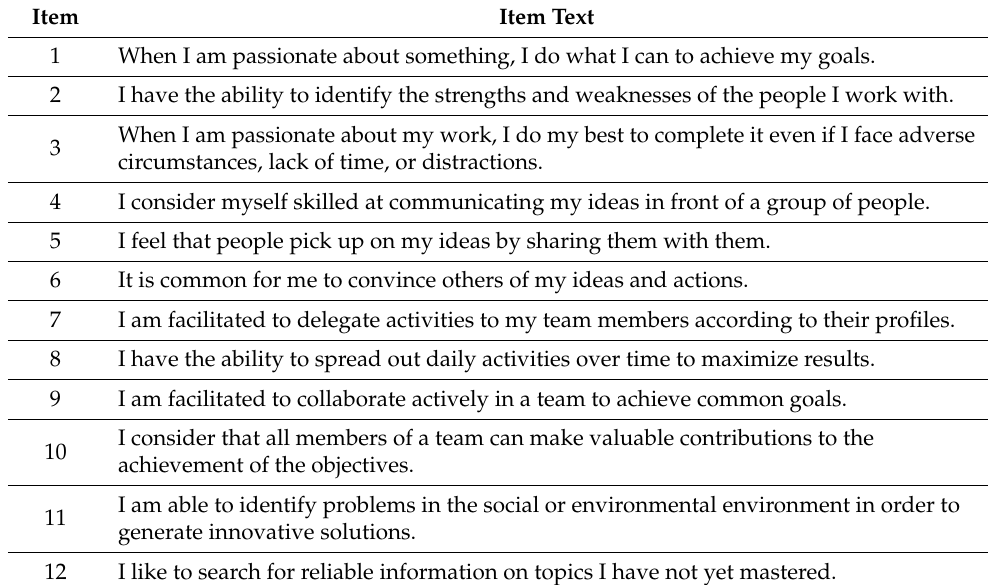
Table 2. Items of the